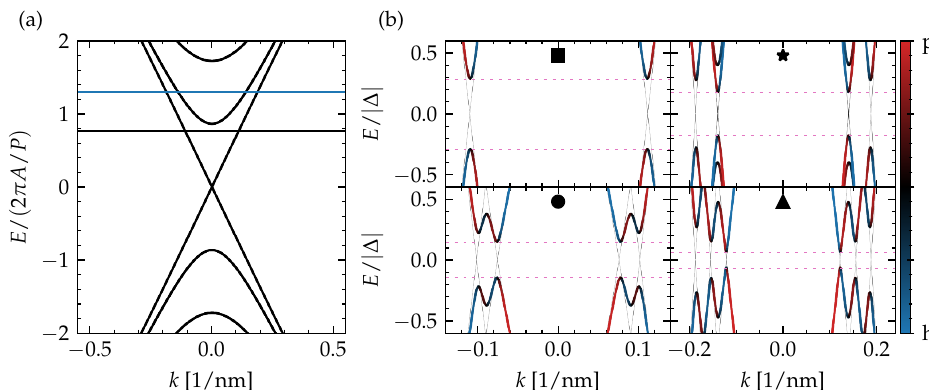
Figure 2. ( a ) The subband-quantized surface-state spectrum of a TI nanoribbon pierced by half a magnetic flux quantum. The two chemical potential values indicated with line cuts in Figure 1c and considered in ( b ) are indicated with horizontal lines; ( b ) the low-energy quasiparticle spectrum of a top-proximitized TI nanoribbon with infinite length for different combinations of piercing magnetic flux and chemical potential, as indicated in Figure 1c, with the color indicating the particle–hole (p-h) mixing (blue for hole, red for particle). The spectrum for ∆ = 0 is presented with thin black lines and the extent of the spectral gap is indicated with horizontal pink dashed